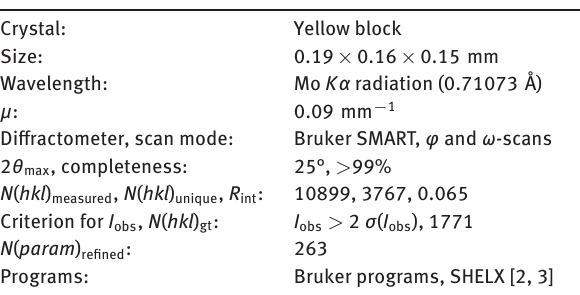
Table 1: Data collection and handling.